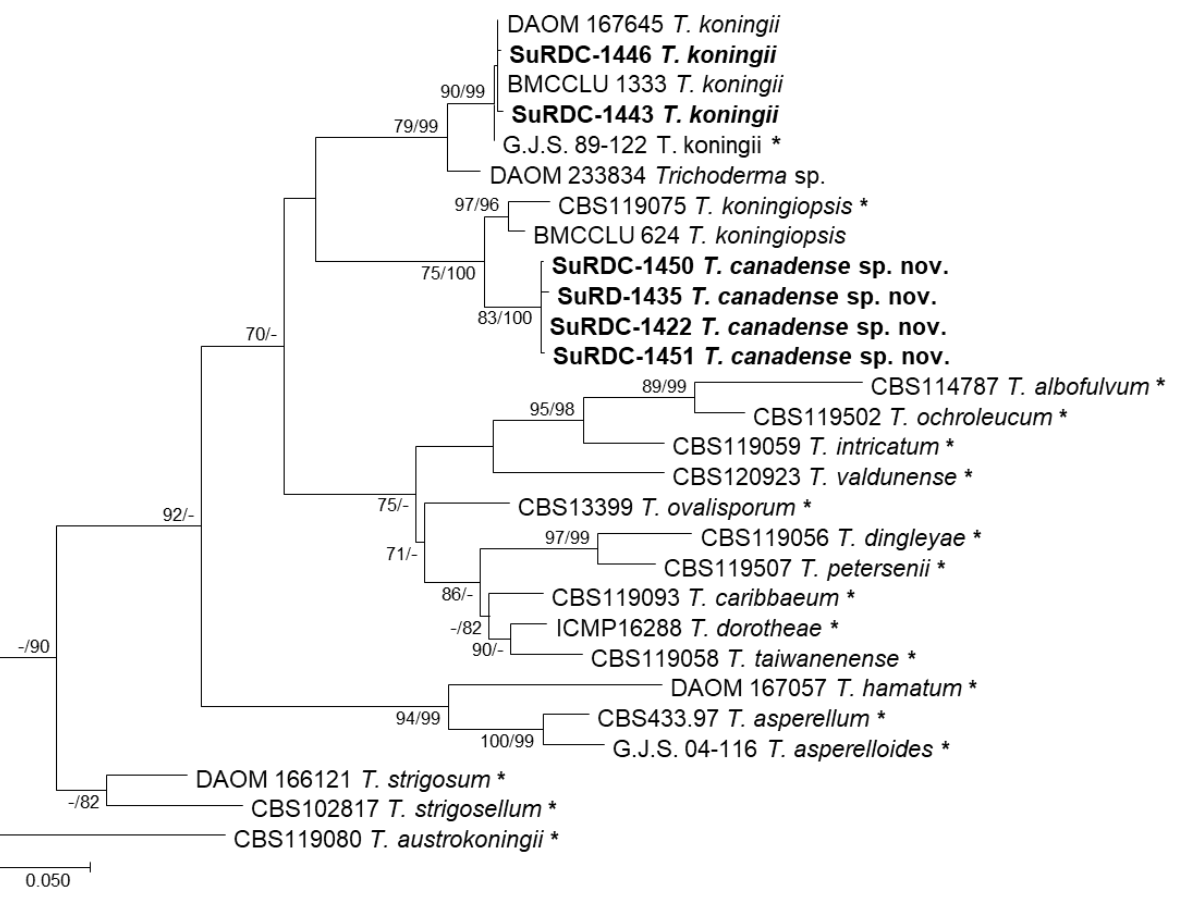
Figure 1. Phylogram of the highest log likelihood tree from an analysis of the TEF1 viride / koningii dataset. Numbers in front of and after the slash represent ML and MP bootstrap values from 1000 replicates, respectively. Values represented by a dash (-) were less than 70% for the bootstrap analyses. Type specimens are indicated with an asterisk and Trichoderma isolates from vineyards in BC are indicated in bold. Bar indicates the number of substitutions per